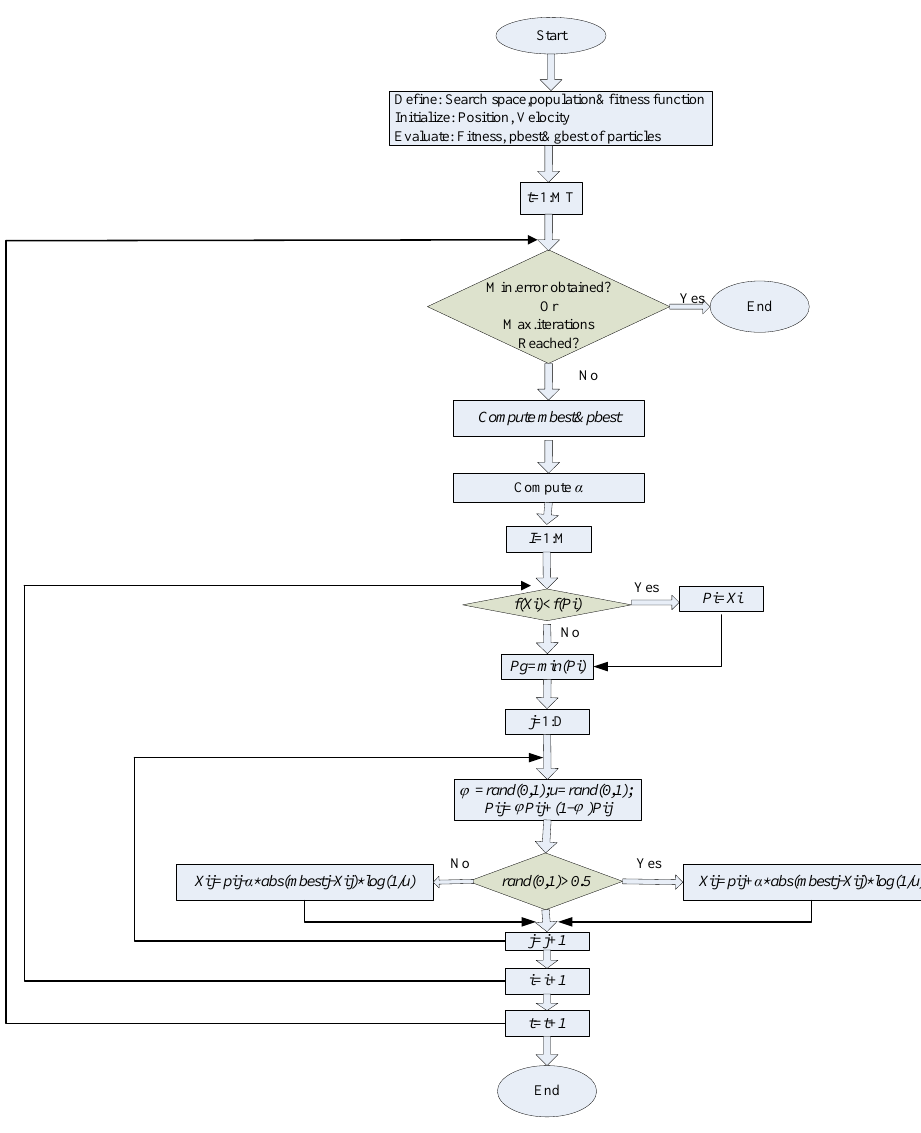
Figure 2. QPSO algorithm flowchart.